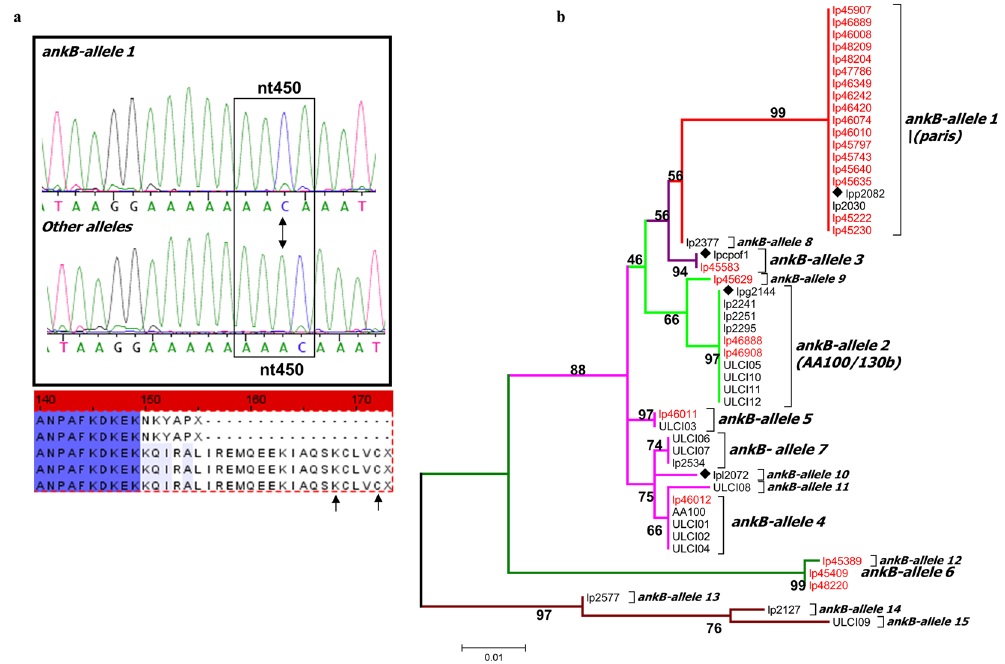
Figure 1. Molecular evolution of ankB . ( a ) Representative sequence chromatograms indicating the frame shift mutation at nucleotide position 450 ( Δ A ) in ankB1 compared to other ankB alleles. This mutation in ankB 1 alters the reading frame and predicts a prematurely terminated AnkB protein at residue 154 and generation of a unique NKYAP sequence motif. Arrows mark the location of the Dot-Icm translocation signal. ( b ) ML analysis of ankB alleles variously from clinical (in black text) and environmental (in red text) isolates. All alleles are indicated. Diamonds indicate ankB sequence from strains whose complete genomes has been determined. Bootstrap values are shown above the branches. The tree is drawn to scale, with branch lengths measured in the number of substitutions per